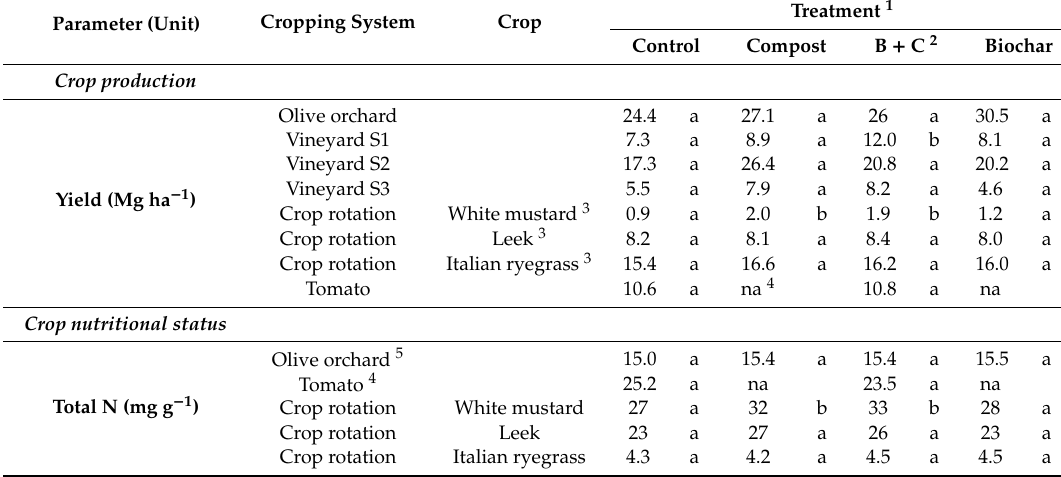
Table 4. Parameters of crop production, nutritional status, and quality at the end of the trial period for di ff erent cropping